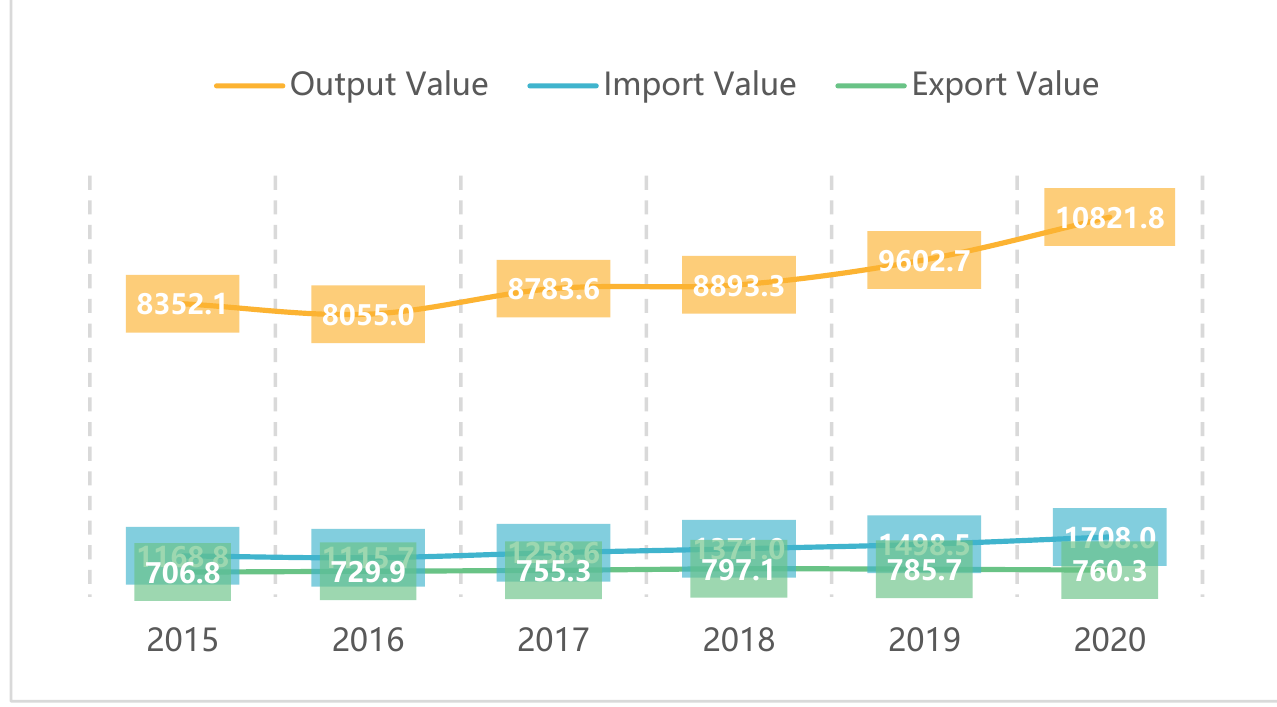
Figure 1. Output value, import, and export value of China’s agri-food products from 2015 to 2020 (Unit: USD 100 million).